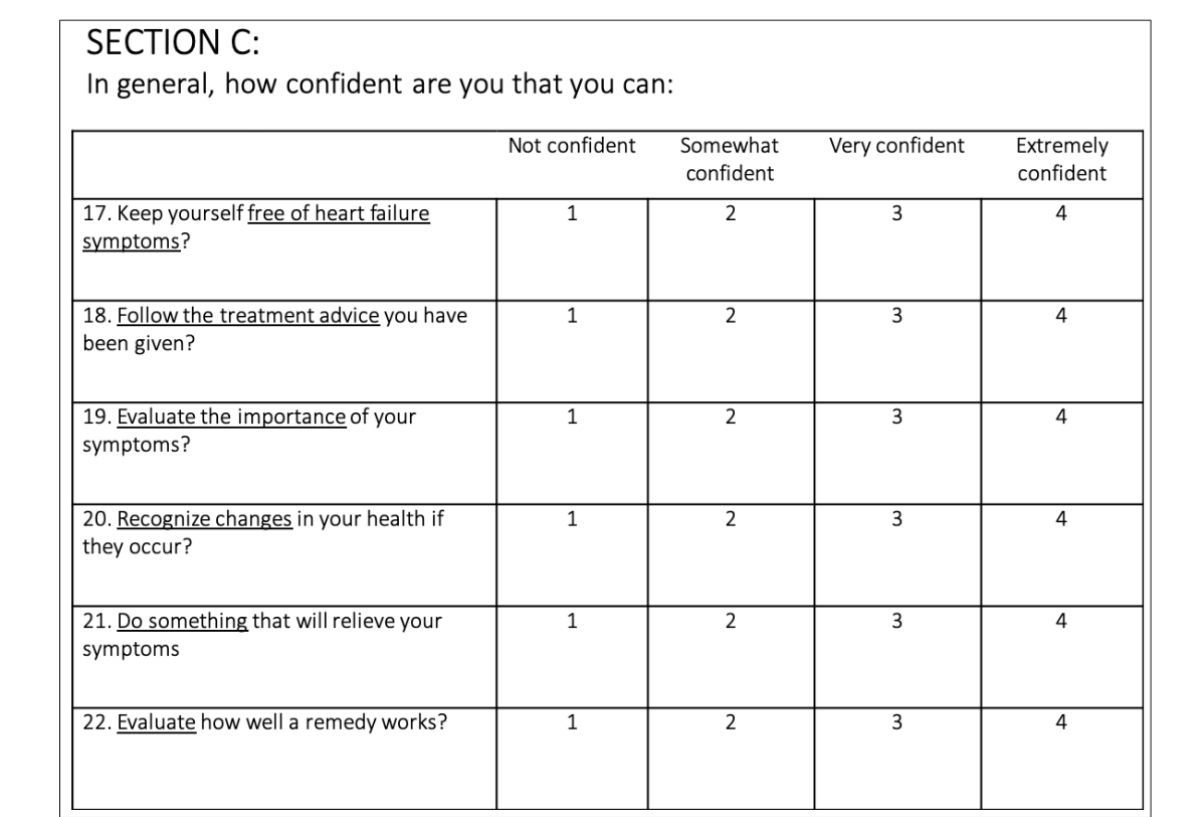
Figure 1. Sample heart failure self-care confidence